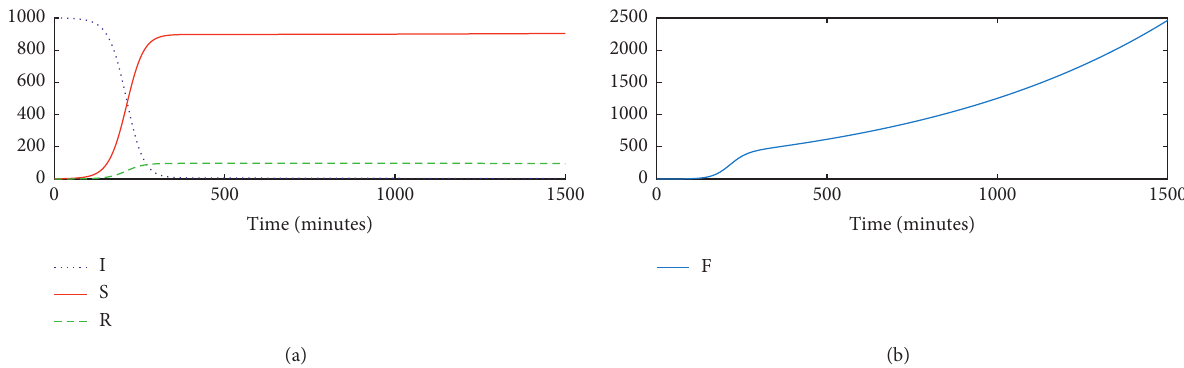
Figure 2: Dynamic of systems (1)–(4) without controls. (a) Behavior of the Ignorant (I), Sharers (S), and Removed (R). (b) The amount of information (F).